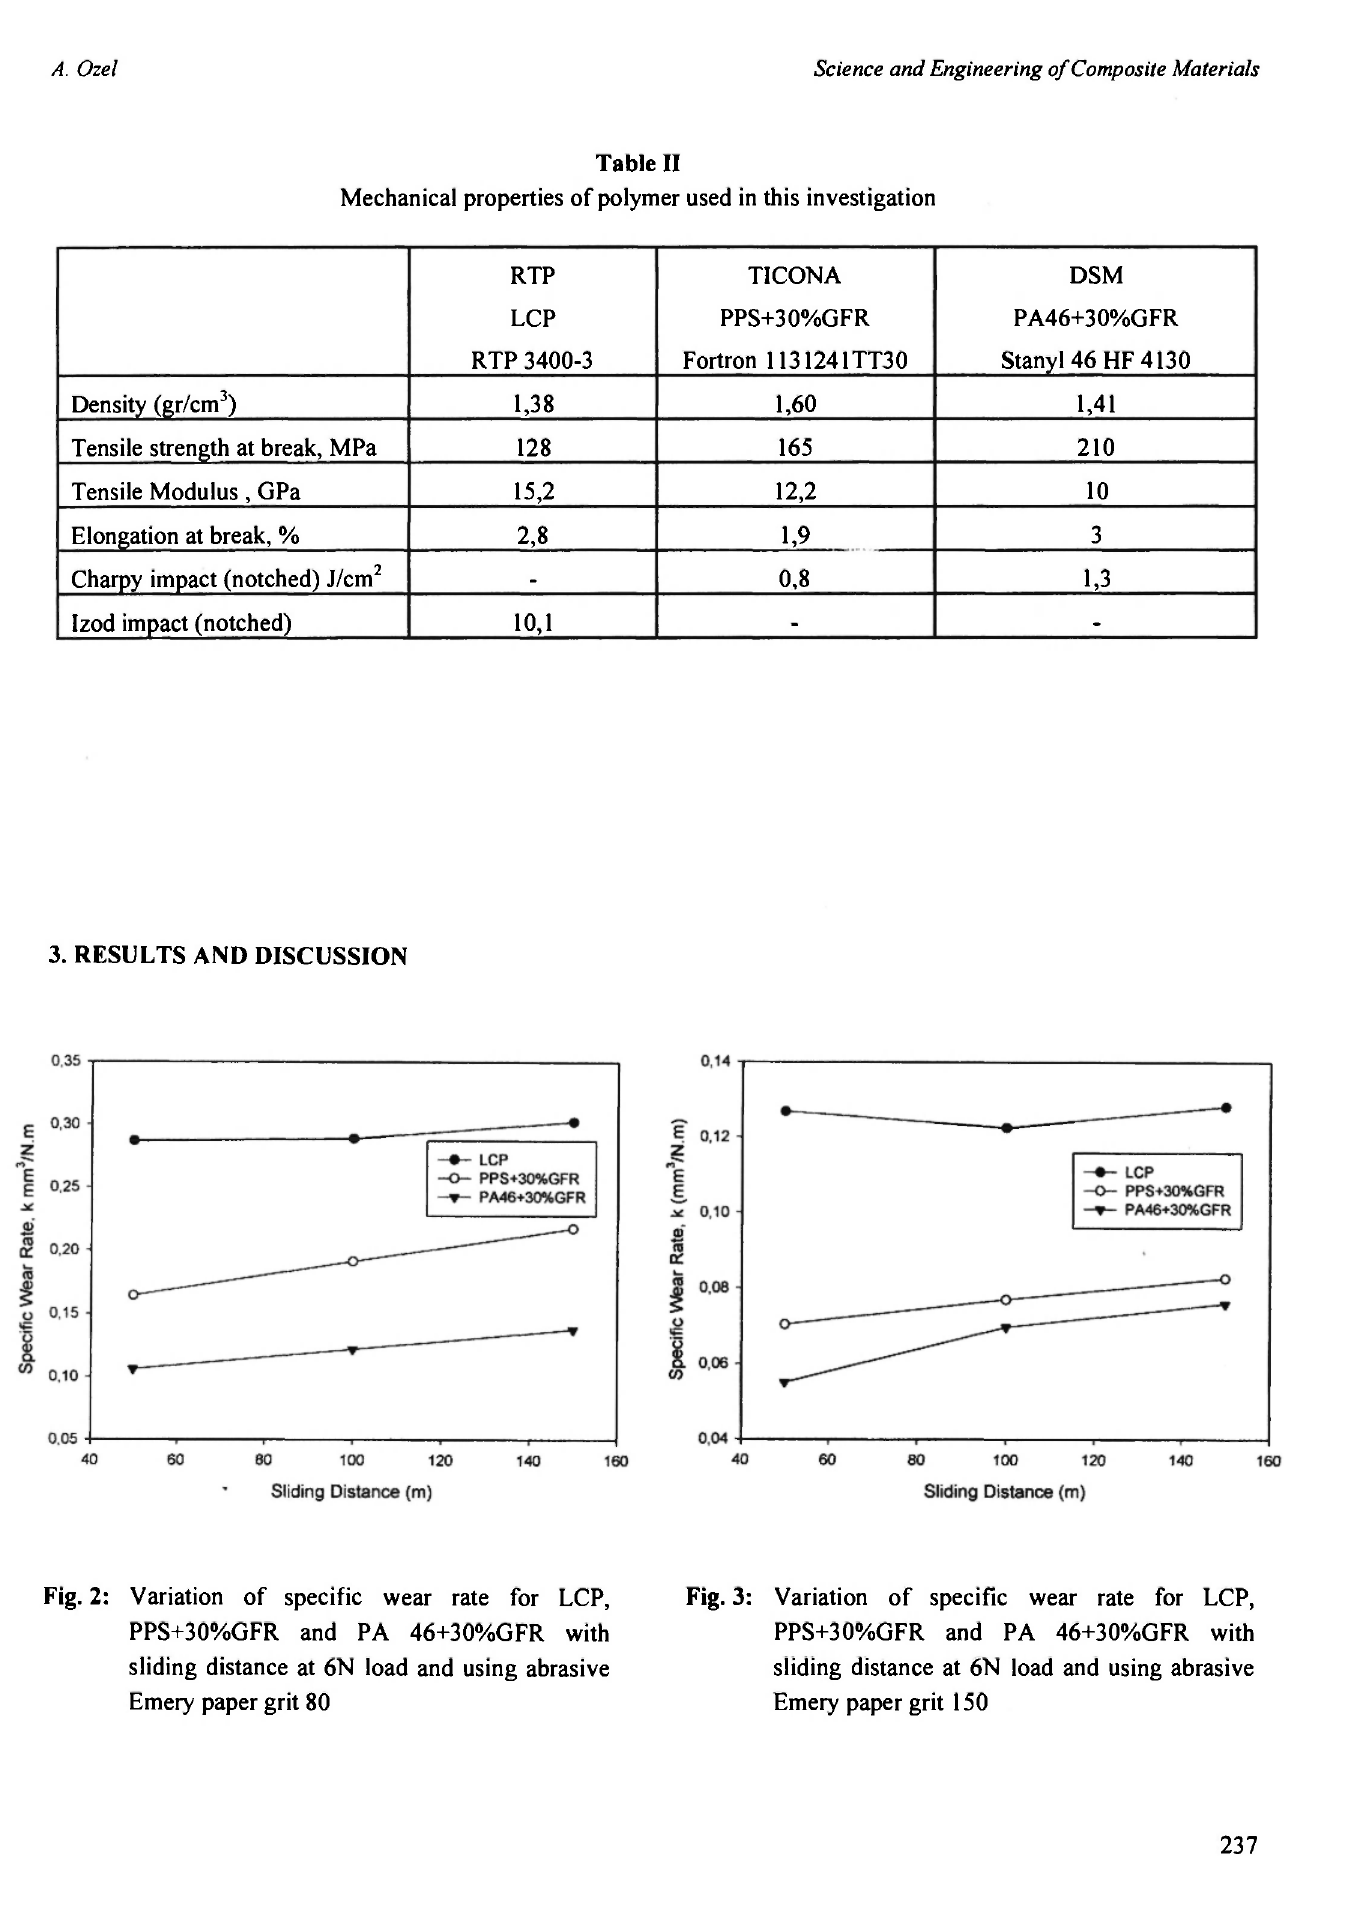
Fig. 2: Variation of specific wear rate for LCP, PPS+30%GFR and PA 46+30%GFR with sliding distance at 6N load and using abrasive Emery paper grit 80